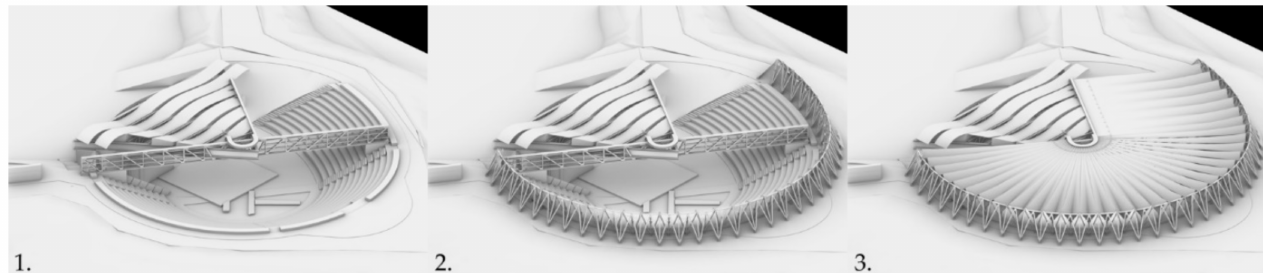
Figure 10. Geometrical concept of the amphitheater in Biała Podlaska. Source: BP Projekt.